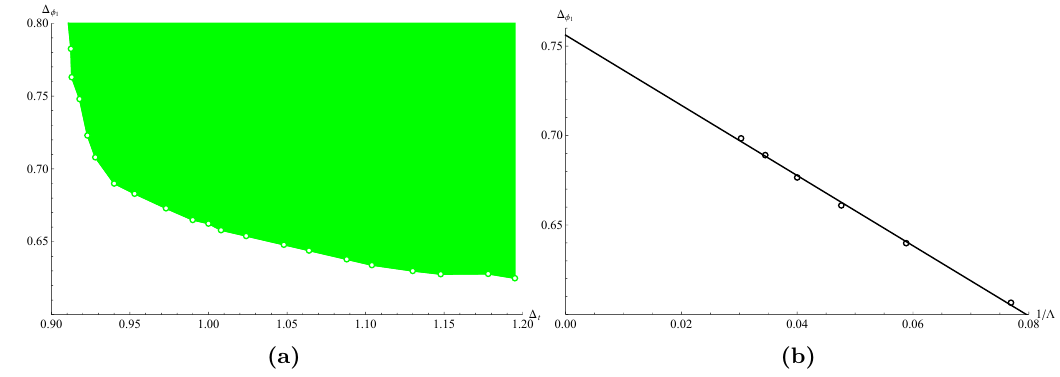
Figure 9. Bootstrapping the O(3) -breaking line defect. In (a), bounds on the scaling dimensions ∆ φ and ∆ t for Λ = 21 , P = 41 . The gaps are given in eq. (4.10). Allowed values of (∆ t , ∆ φ 1 given in green. In (b), the bound on ∆ φ for which a fit is